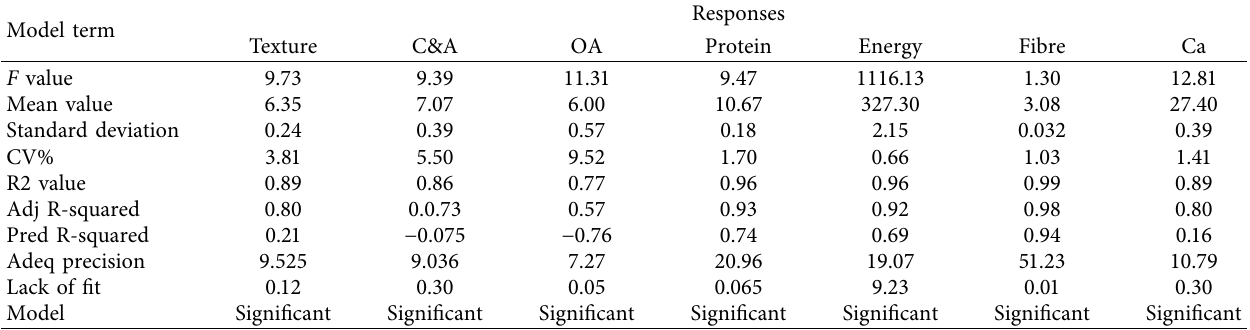
Table 1: Regression coefficients of the quadratic model and ANOVA for different attributes of fruit peel